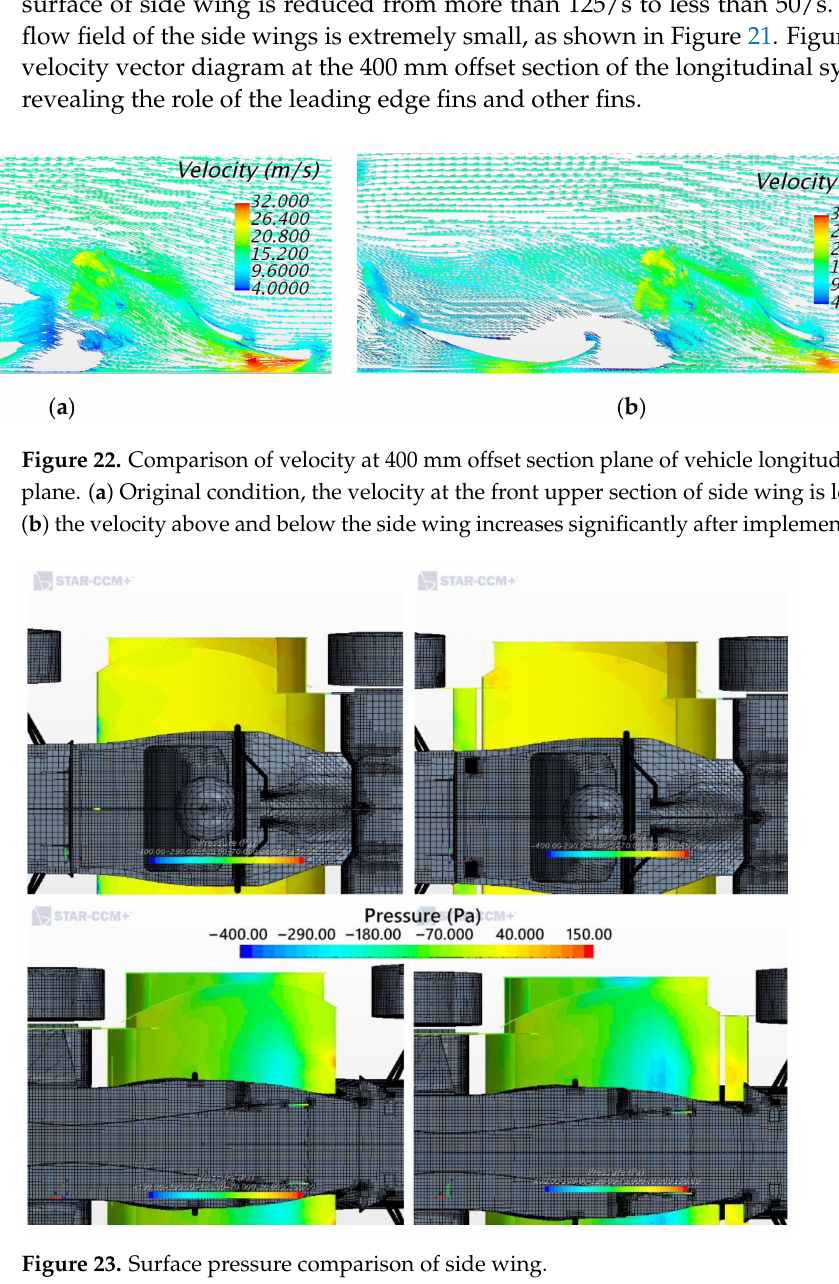
Figure 23. Surface pressure comparison of side